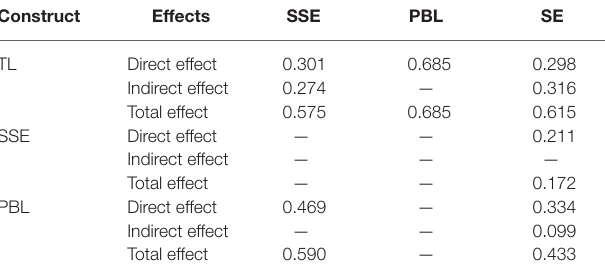
TABLE 3 | Path coefficient of direct, indirect, and total effects.